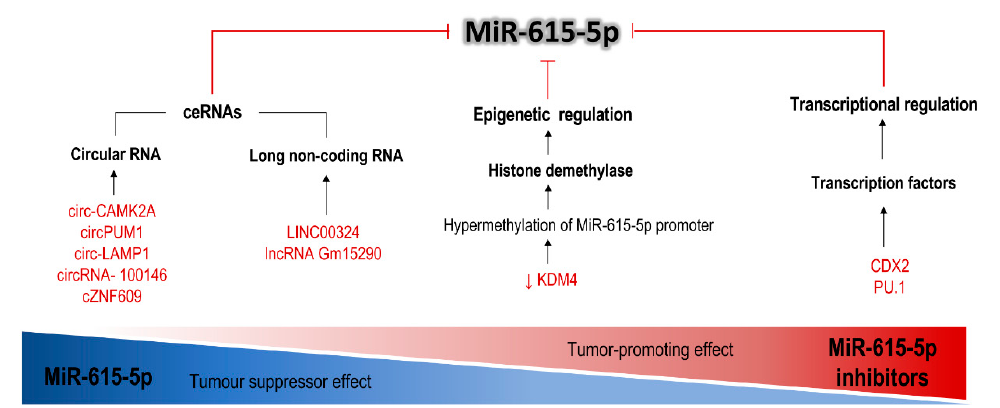
Figure 3. miR-615-5p can be negatively regulated under three di ff erent paradigms, according to the evidence available at present. It is possible to block the action of the molecule by ceRNAs, either circRNAs or lncRNAs. It is also susceptible to repression by hypermethylation of its intragenic promoter, which has been related to deficiencies in the action of demethylases such as KDM4. Finally, the expression of this miRNA is positively and independently regulated by transcription factors which, when repressed, cease to induce the expression of miR-615-5p. The functional consequence of this inhibition is the abolition of its tumor suppressor e ff ect, which finally leads to the oncogenic e ff ect associated with the decrease in miR-615-5p